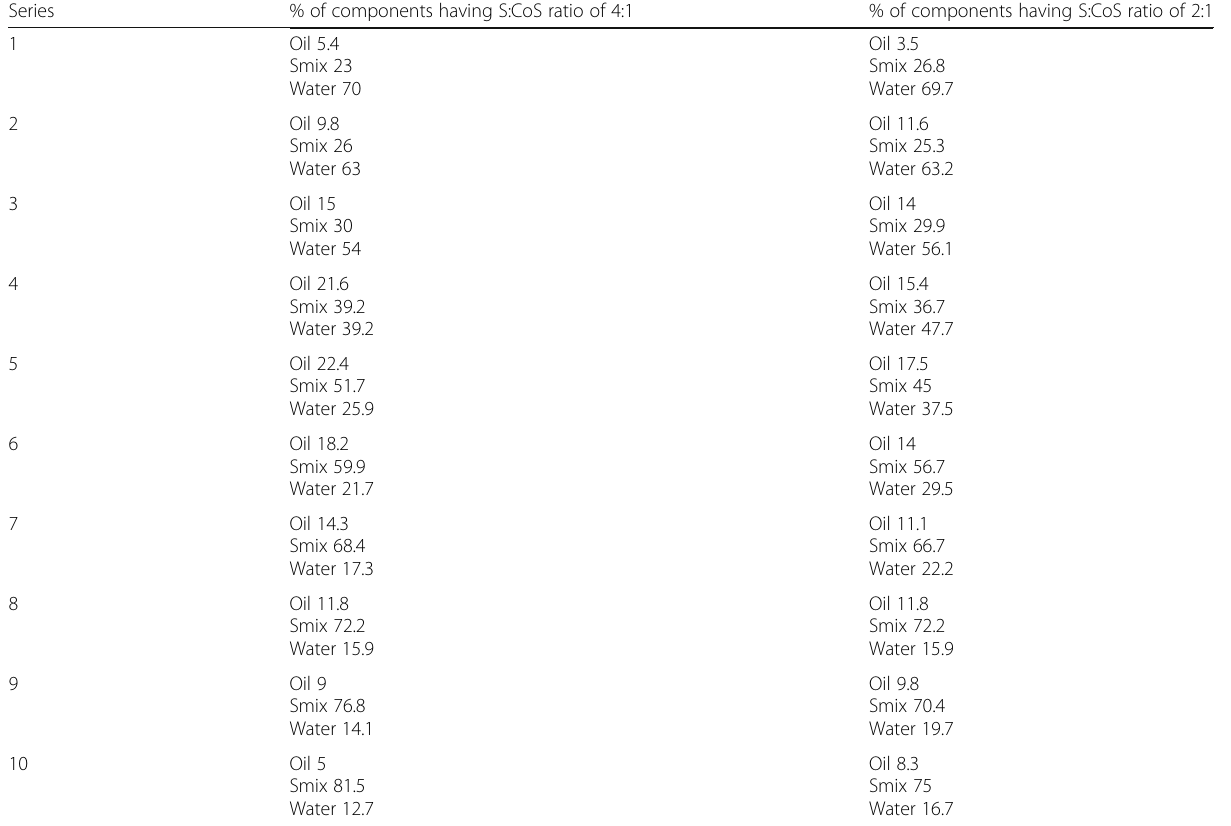
Table 4 Boundary point composition of microemulsion formulation having S:CoS ratio of 4:1 and 2:1